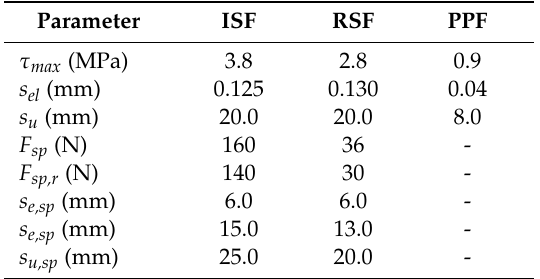
Table 3. Calibrated values for the fibers bond-slip